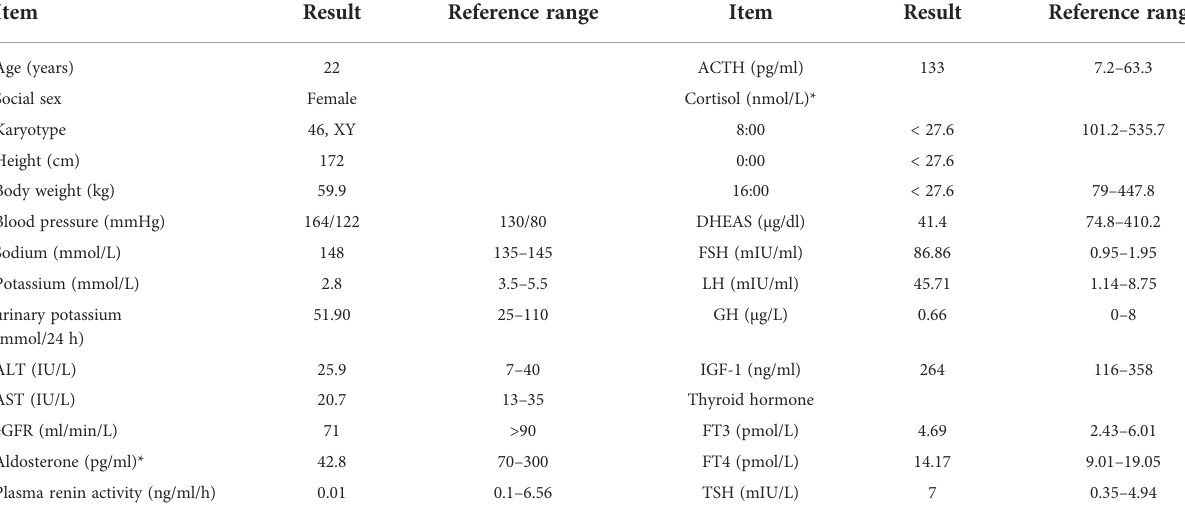
TABLE 1 Clinical manifestations and general blood examination results in this